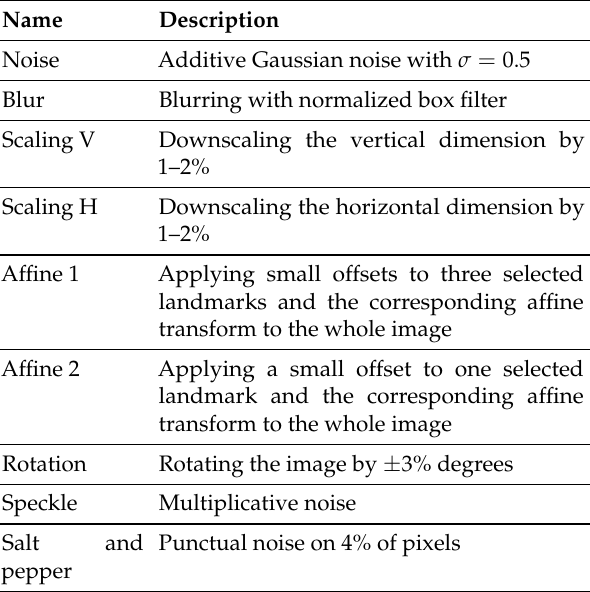
Table 4. Manipulations applied for the robustness test.